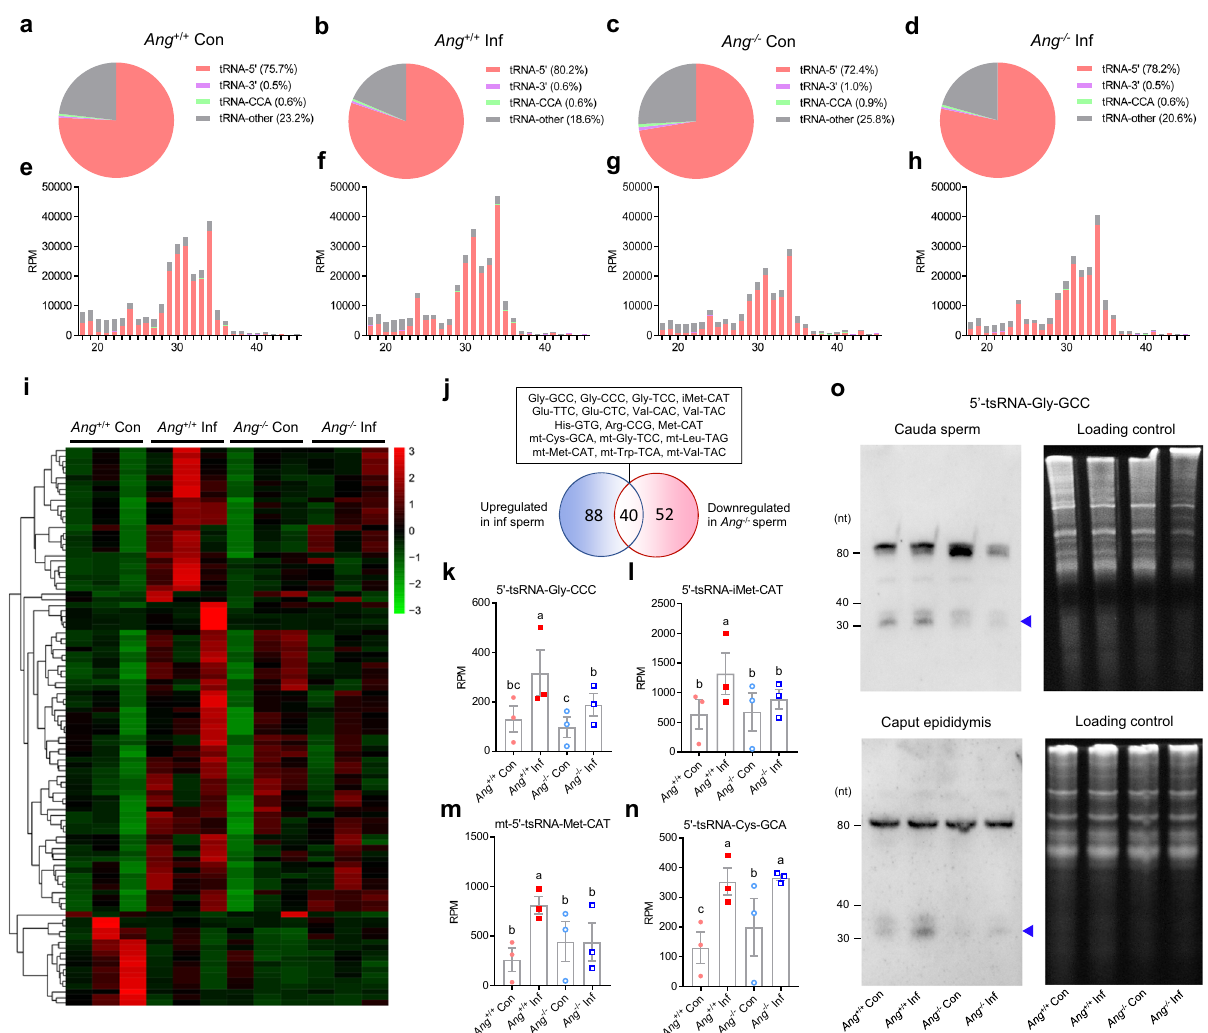
Fig. 3 Sperm tsRNAs pro fi le in in fl ammatory and Ang -deleted mice. Male Ang + / + and Ang – / – mice were treated with LPS (Inf) or saline (Con) once every other day for a total of four injections in 7 d to establish an in fl ammatory model. Small RNA deep sequencing was performed on cauda sperm isolated from Ang + / + Con, Ang + / + Inf, Ang – / – Con, and Ang – / – Inf mice. Sperm total RNAs extracted from two mice were mixed together for Small RNA deep sequencing. a – d Subcellular fractionation of tsRNAs (5 ′ -tsRNAs, 3 ′ -tsRNAs, CCA-tsRNAs, and other tsRNAs) in Ang + / + Con ( a ), Ang + / + Inf ( b ), Ang – / – Con ( c ), and Ang – / – Inf ( d ) sperm. e – h Length distribution and pattern changes of different tsRNAs in Ang + / + Con ( e ), Ang + / + Inf ( f ), Ang – / – Con ( g ), and Ang – / – Inf ( h ) sperm. i Heat map of differentially expressed 30 – 35 nt 5 ′ -tsRNAs in sperm. j Venn diagram showing numbers of 5 ′ -tsRNAs with signi fi cant upregulated in sperm from in fl ammatory mice and downregulated in sperm from Ang-deleted mice. k – n Expression levels of select 5 ′ -tRNAs that are altered with in fl ammation and Ang deletion. Statistical analysis was performed by two-tailed, one-way ANOVA, uncorrected Fisher ’ s LSD. n = 6 mice per group. All data are plotted as mean ± SEM. Values with different superscripts are signi fi cantly different from each other ( P < 0.05). o Northern blot analyses of 5 ′ tsRNA-Gly (shown by arrow heads) in Ang + / + Con, Ang + / + Inf, Ang – / – Con, and Ang – / – Inf cauda sperm and caput epididymis. n = 6 mice per group. Sperm total RNAs extracted from two mice were mixed together for each lane in the experiment. Sperm total RNAs were run on a 15% denatured PAGE gel as shown as a loading control. Blots are shown as representatives of three independent experiments with similar results. Source data are provided as a Source Data fi